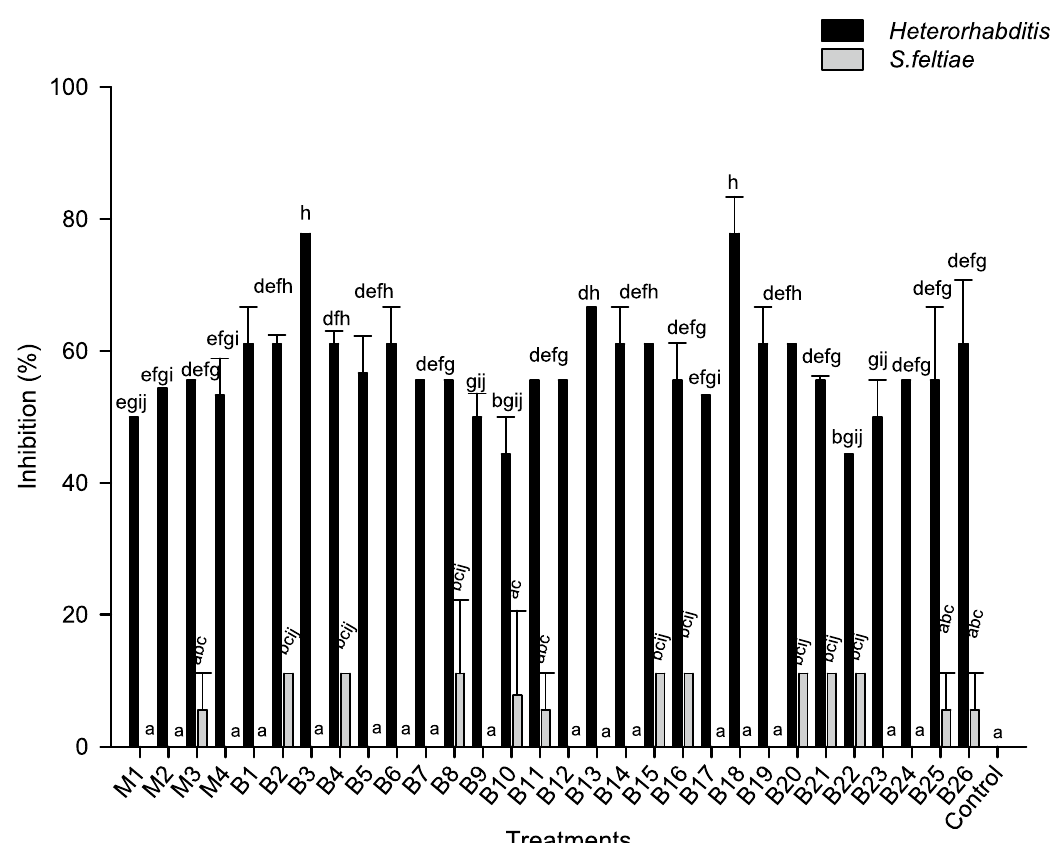
Fig. 3 Inhibition of fungal growth by bacteria isolated from entomopathogenic